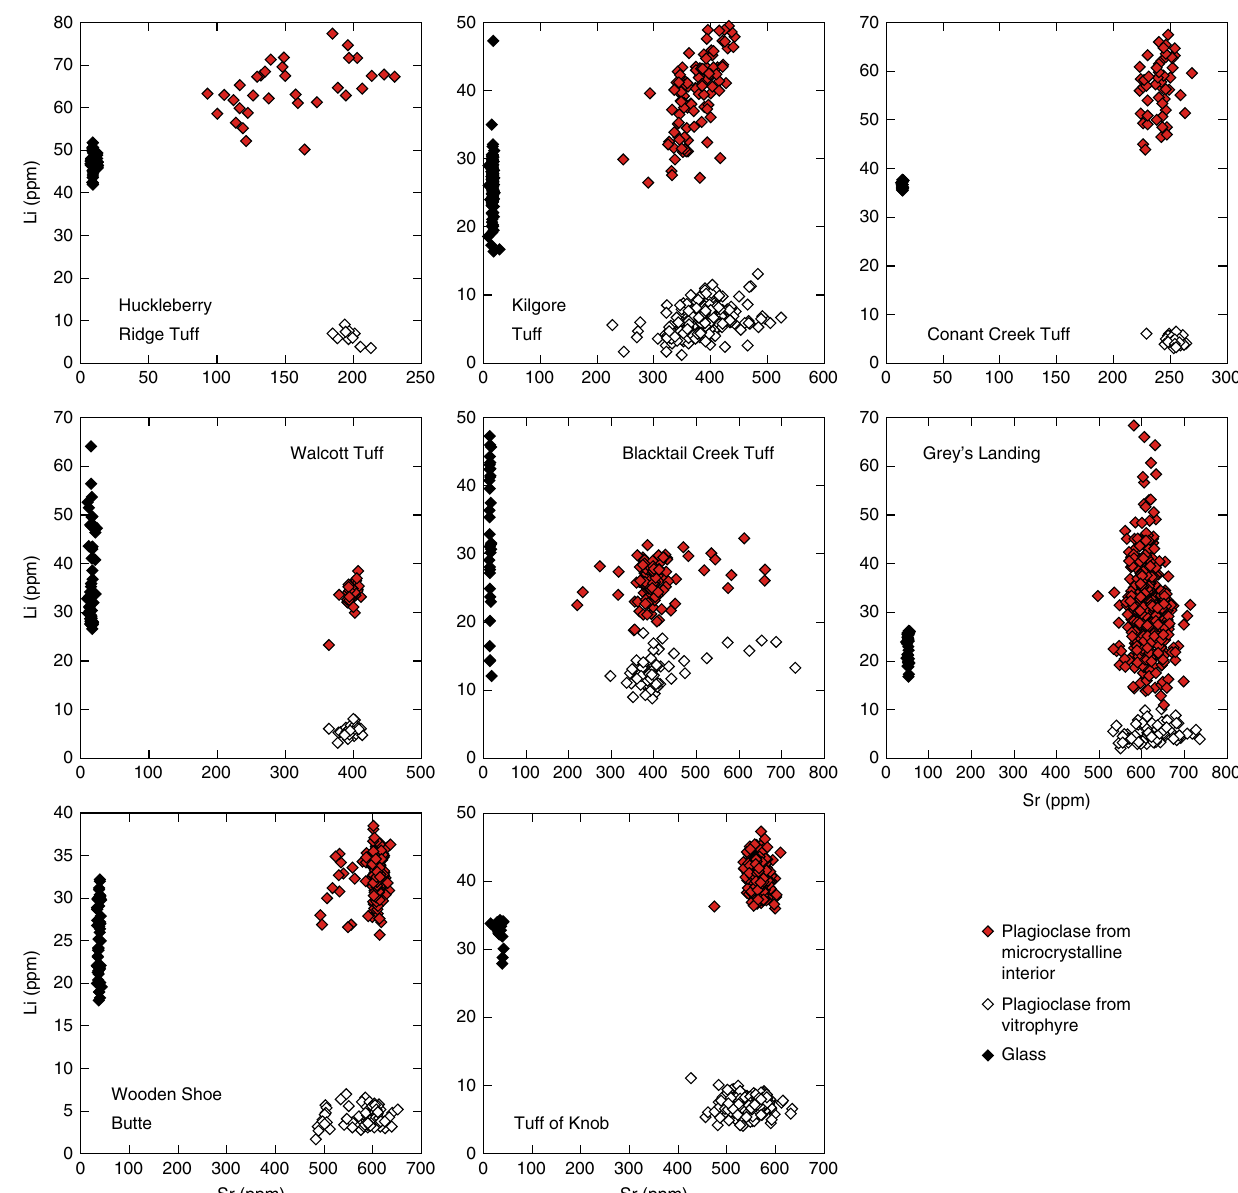
Fig. 3 Lithium abundances in plagioclase crystals and glass from rhyolites considered in this study. Plagioclase crystals from the microcrystalline portion of the deposit have consistently higher Li contents than those from the glassy portions of the same deposit (full data in Supplementary Data 1). Typical uncertainties for Li and Sr are <5% (2 σ ). Grey ’ s Landing data are from ref.